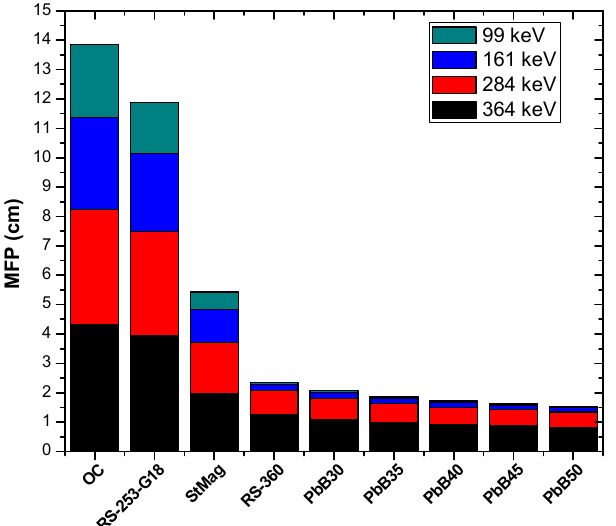
Figure 9. Comparison of MFP value of PbB30–50 glasses with those of some conventional shield at 99, 161, 284 and 364 keV.